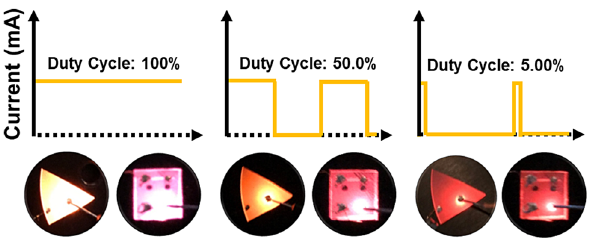
Figure 10: As the duty cycle of a pulsed current with a frequency of 10 kHz and a constant peak current is decreased, the emission color changes from yellow to red or from pink to red for the Eu-doped GaN samples with and without Mg-Si codoping, respectively [Reprinted (adapted) with permission from a study by Mitchell et al. [22], Copyright 2019, American Chemical Society].